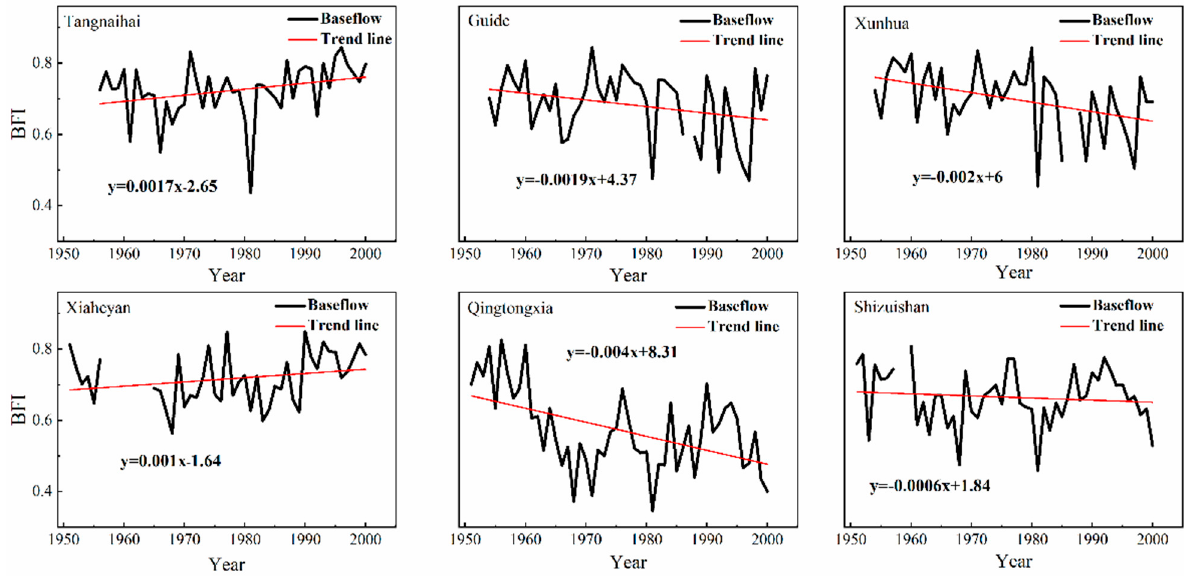
Figure 3. Interannual variation in BFI at all the hydrological gauging stations.